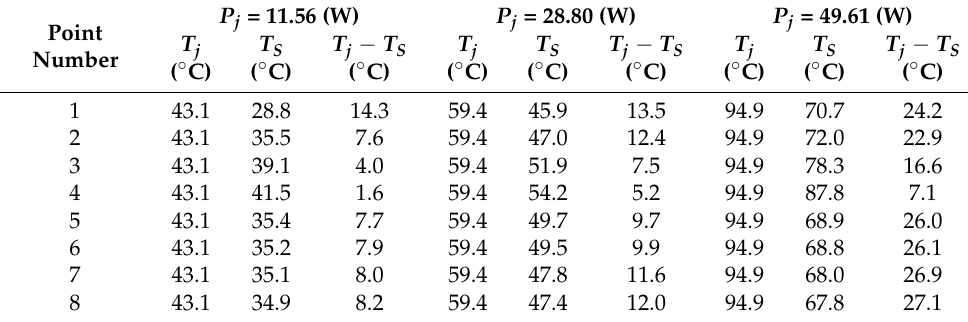
Figure 16. The simulation result showing the heat sink for a power of Pj = 117.99 W: ( a ) side view; ( b ) cross section. The temperature ranges from 20 °C to 165 °C. Table 6. The differences between the junction temperature ( T j ) and the temperatures at the points shown in Figure 2 ( T S ) for P j = 11.56 W, P j = 28.80 W and P j = 49.61